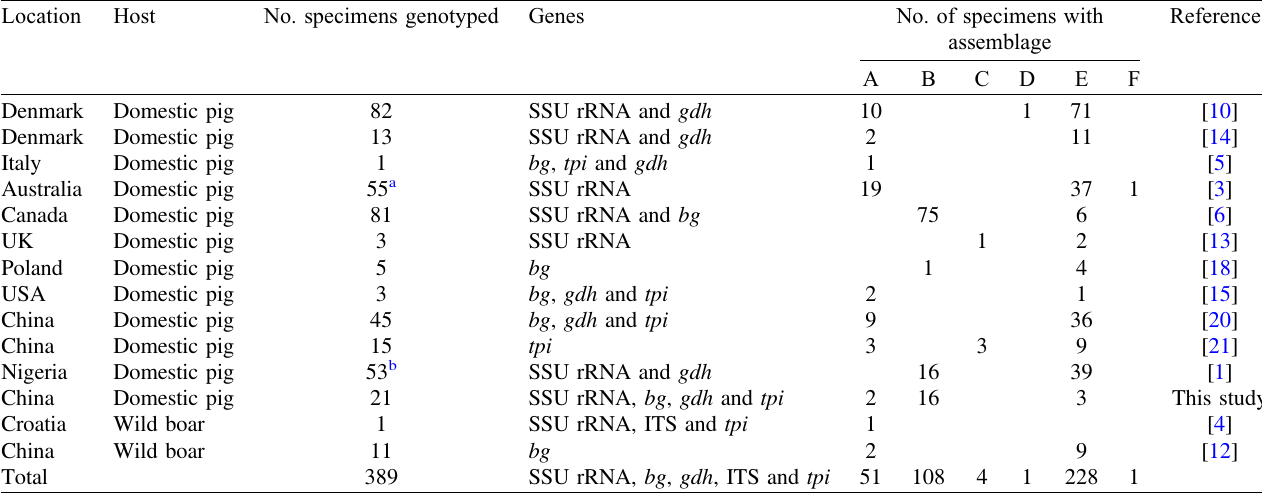
Table 4. Global distribution of assemblages of Giardia duodenalis in pigs.